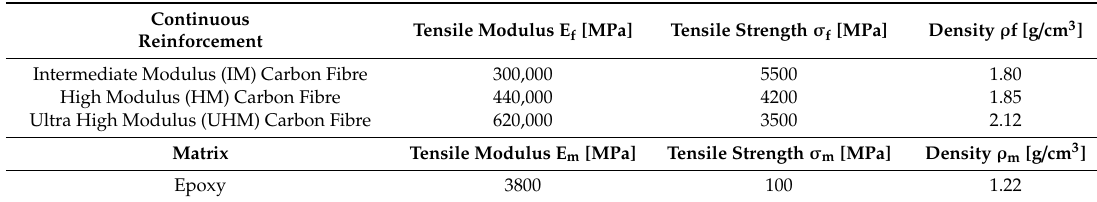
Table 4. The reinforcements and the matrix properties.